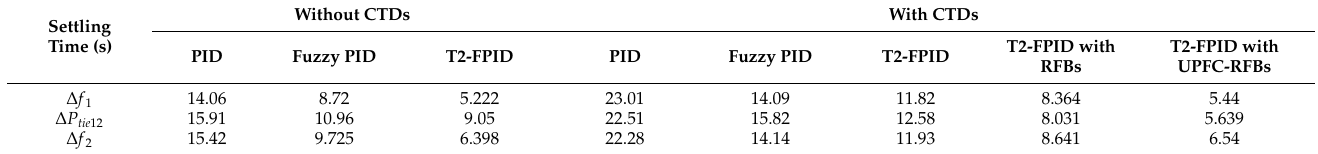
Table 4. Settling time of responses in various cases for test system